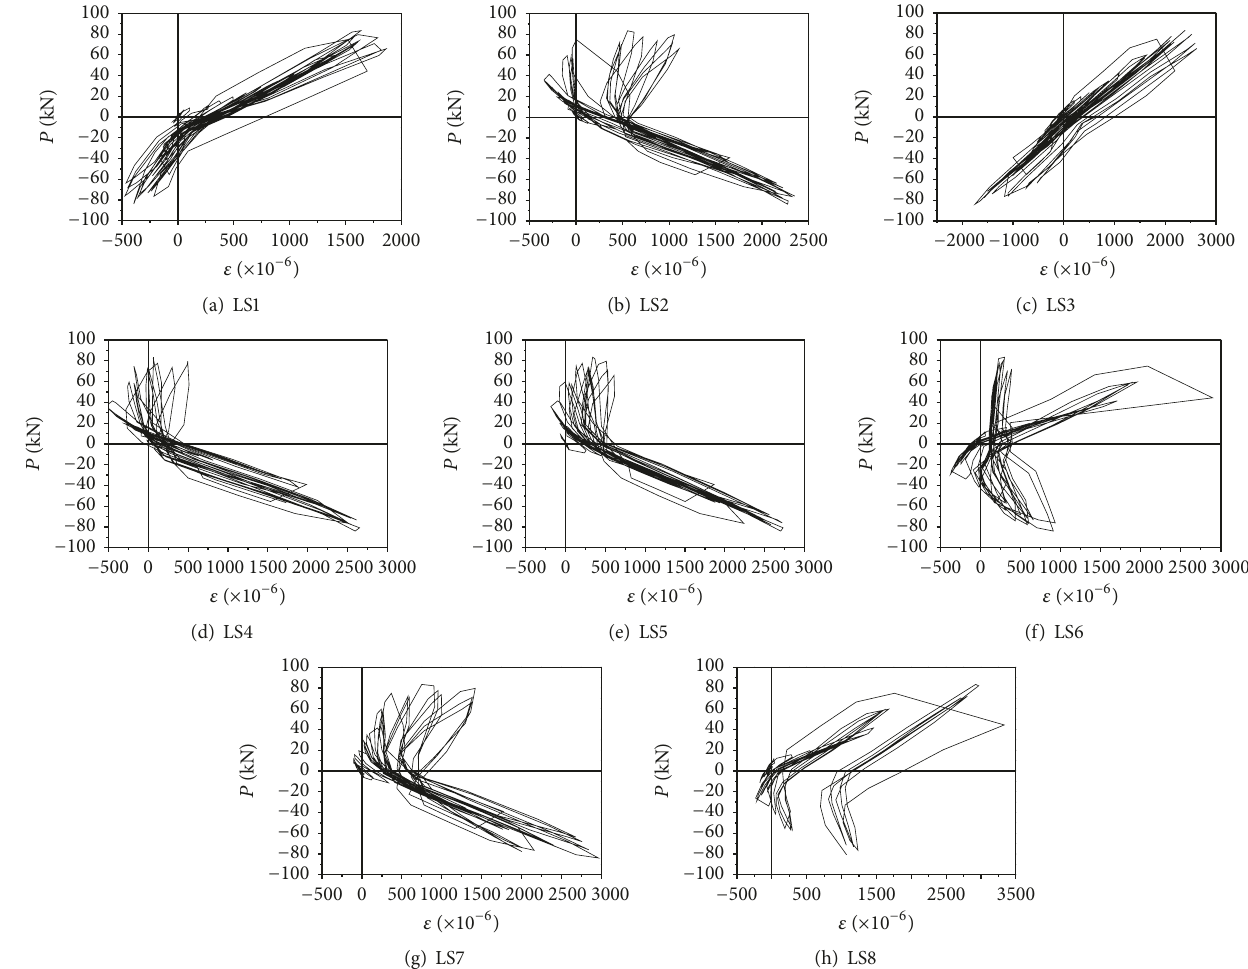
Figure 5: Load-strain hysteresis curve of specimen ZJ1 longitudinal steel bar.